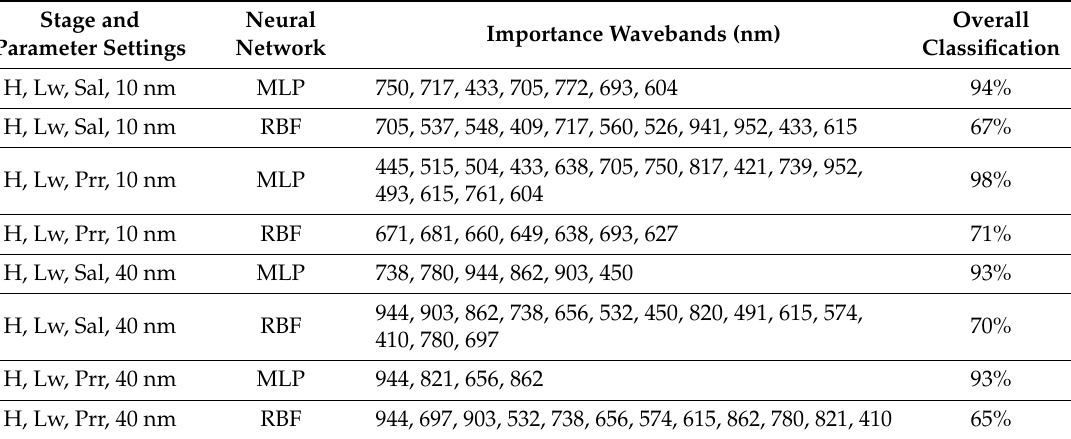
Table 5. Reflectance classification using MLP and RBF methods for laurel wilt (Lw), Healthy (H),